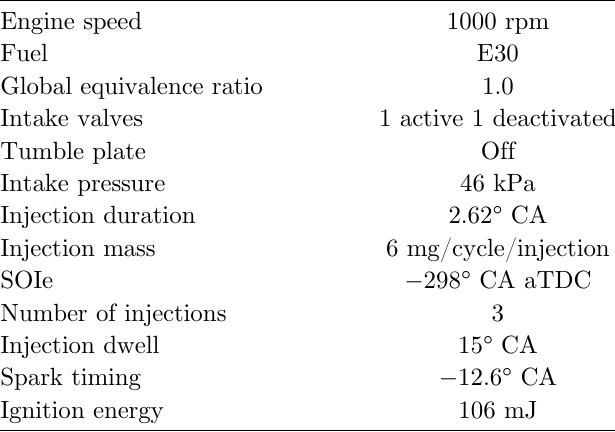
Table 2. Summary of experimental operating condition of the DISI